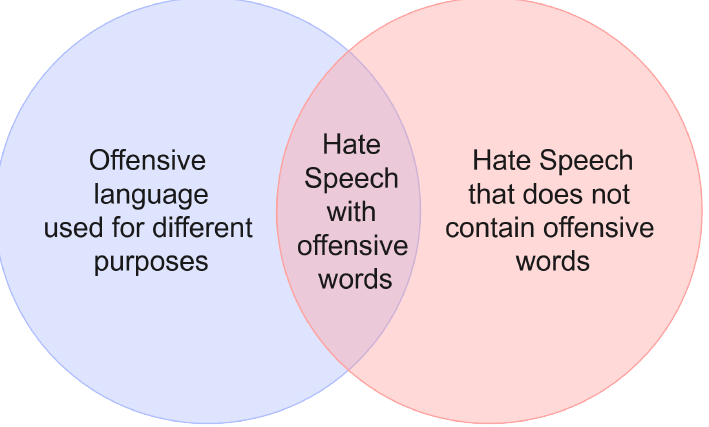
Figure 1. Venn diagram of positive labels used in the Datasets studied by this